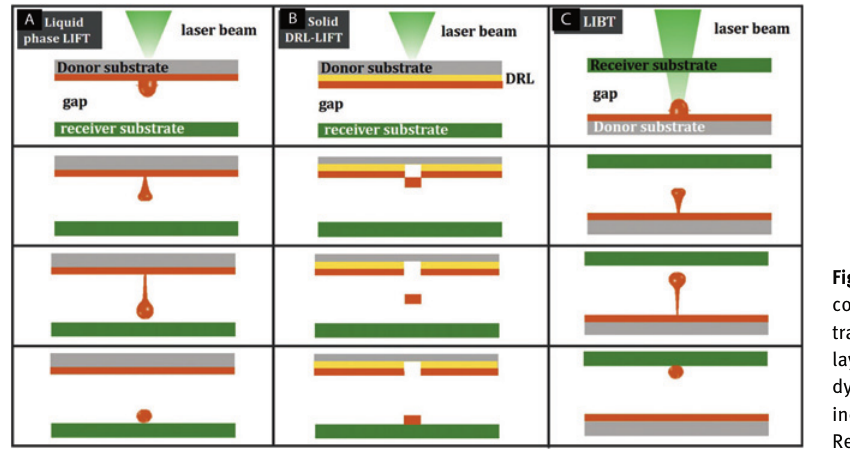
Figure 2: Illustrations of typical LIT configurations: (A) laser induced forward transfer (LIFT) with a liquid phase donor layer, (B) LIFT with a solid donor layer and dynamic release layer (DRL), and (C) laser induced backward transfer